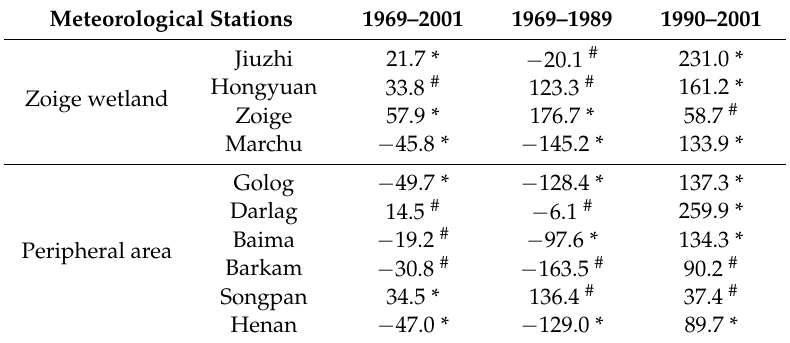
Table 4. The annual trends in the observed E pan in Zoige wetland and its peripheral area at different stages (unit: mm decade − 1